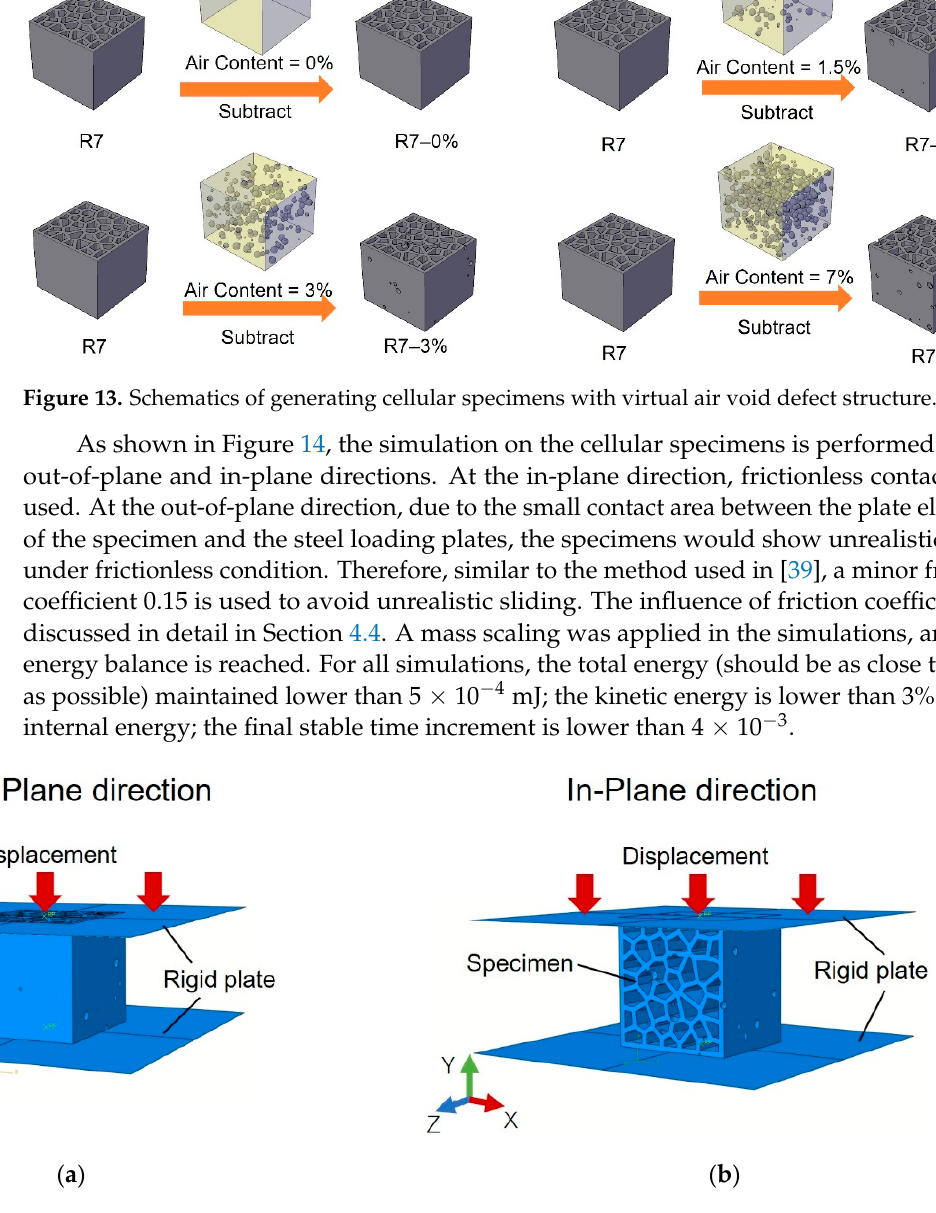
Figure 12. Distribution of air void radius.